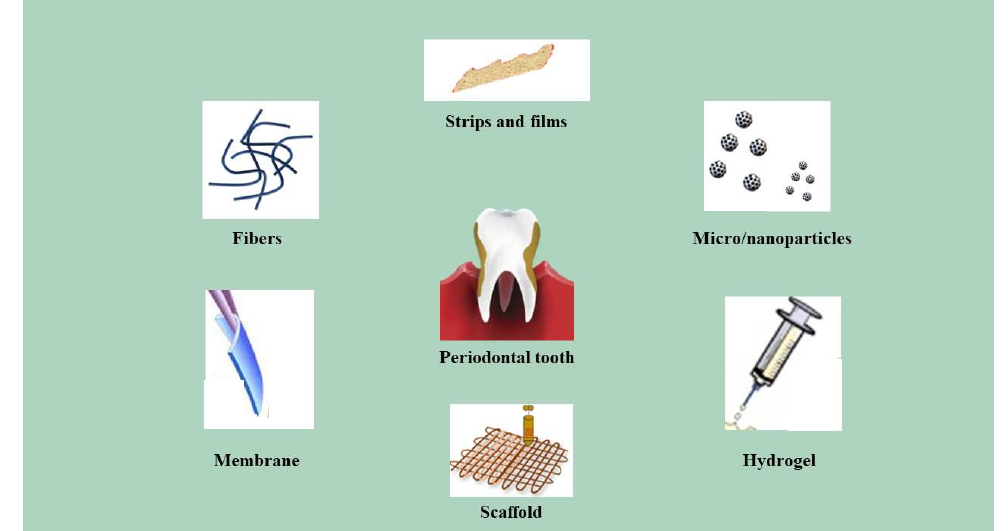
Figure 1. The available LDDSs for periodontal treatment.